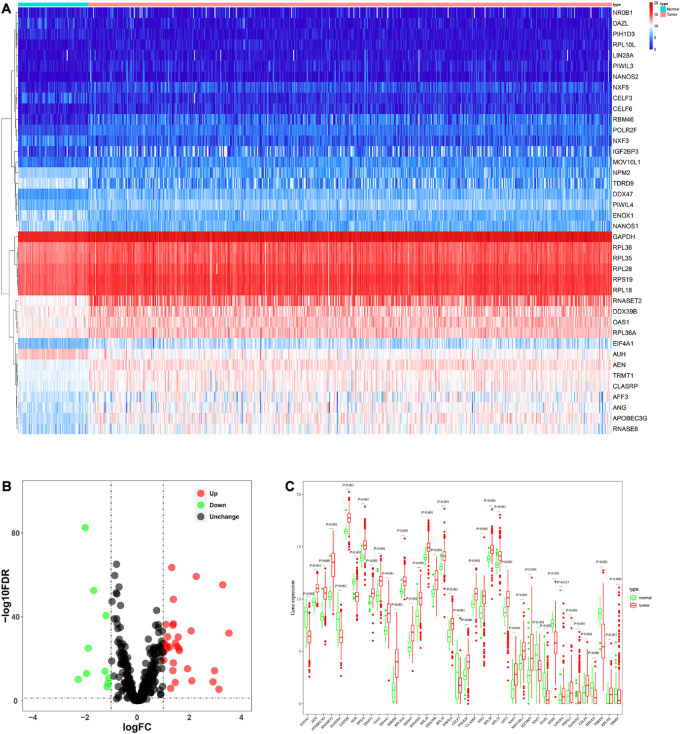
The expression and distribution of differentially expressed RBPs in ccRCC. (A) Heatmap of the 40 differentially expressed RBPs; (B) Volcano plot of 455 RBPs (C) visualization of the expression levels of the 40 differentially expressed RBPs.